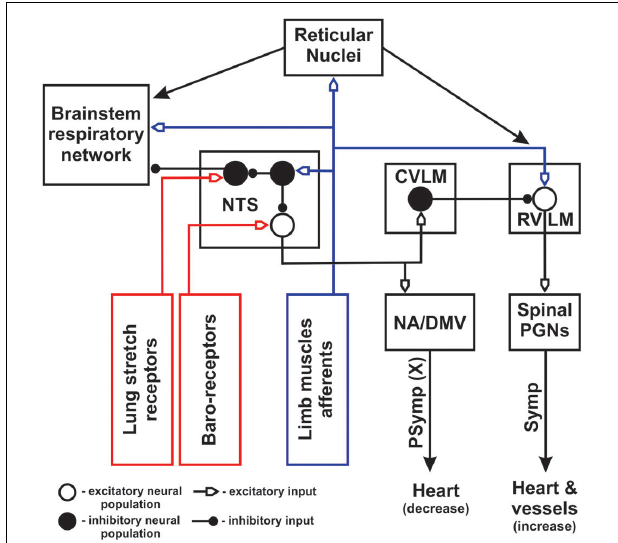
FIGURE 3 | Schematic diagram of cardio-respiratory interactions during exercise. Blue color represents afferent feedback from limb muscles. Red color shows afferent feedback from baro- and lung stretch receptors. NA – nucleus ambiguous; DMV – dorsal motor nucleus of vagus; PGNs – preganglionic neurons; Symp – sympathetic outputs; PSymp – parasympathetic output; X – vagus nerve. Open and filled big circles represent excitatory and inhibitory neuron populations, respectively. Filled small circles show inhibitory inputs, open small arrows indicate excitatory inputs. NTS was moved out from the block presenting brainstem respiratory network to show its inputs and outputs in greater details. Peripheral/central chemoreception was not included for